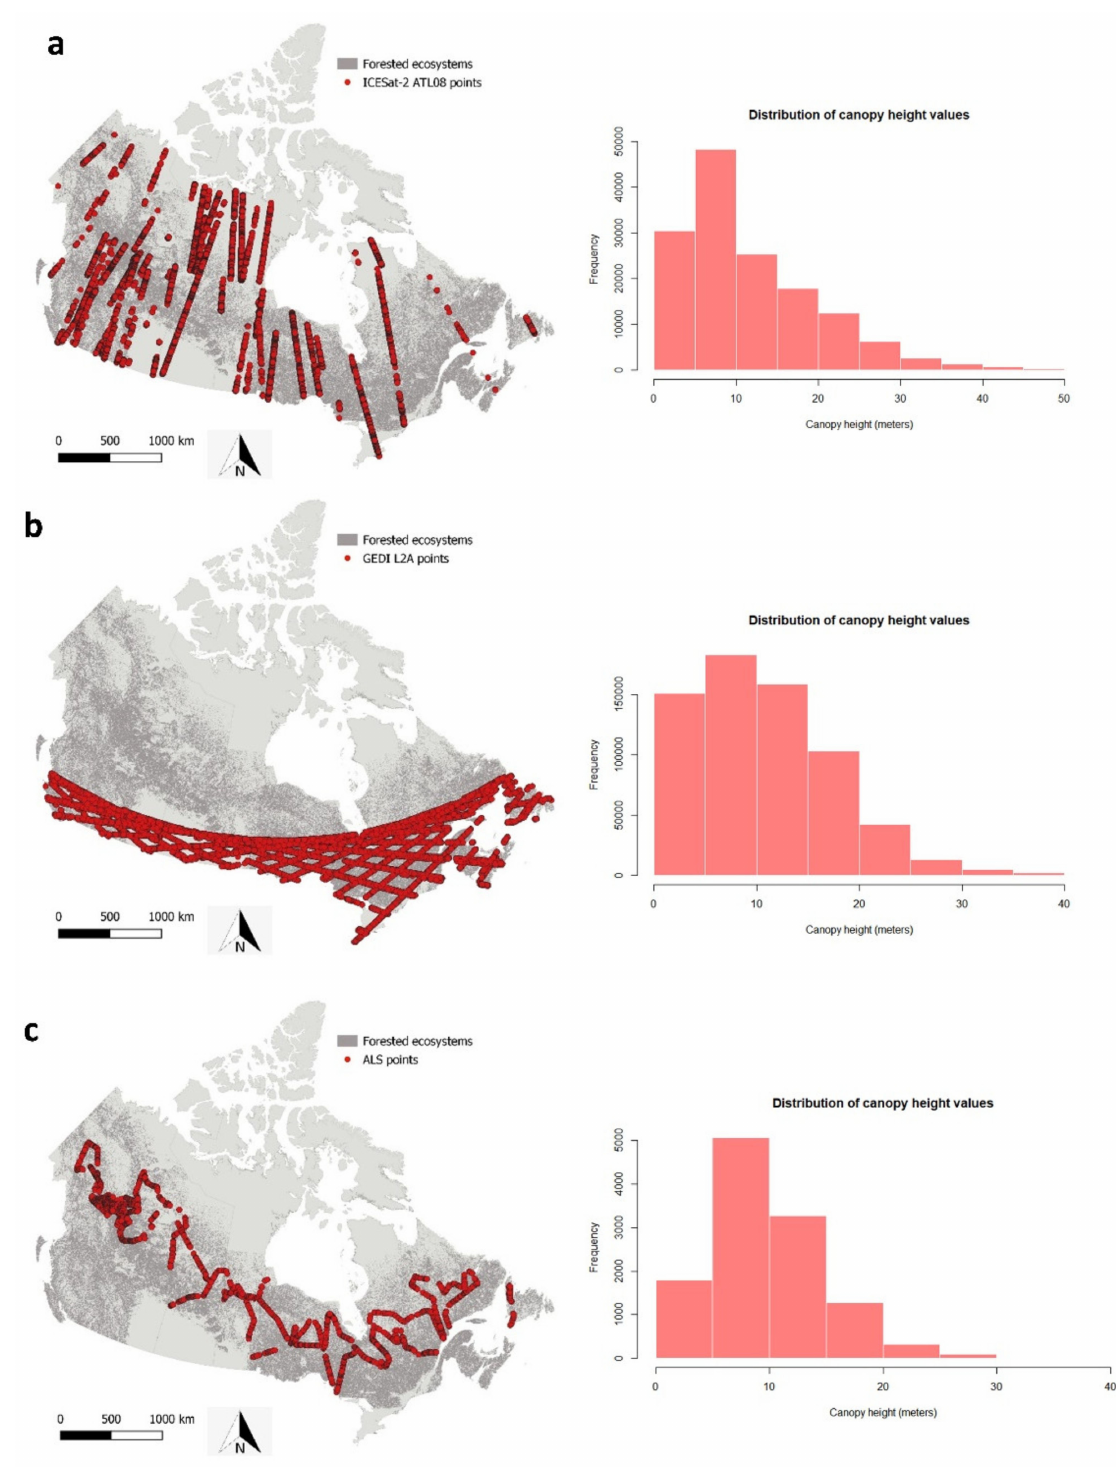
Figure 1. Distribution of LiDAR samples in Canada ( left ) and corresponding histogram with canopy height classes ( right ). ( a ) ICESat-2 ATL08. ( b ) GEDI L2A. ( c )